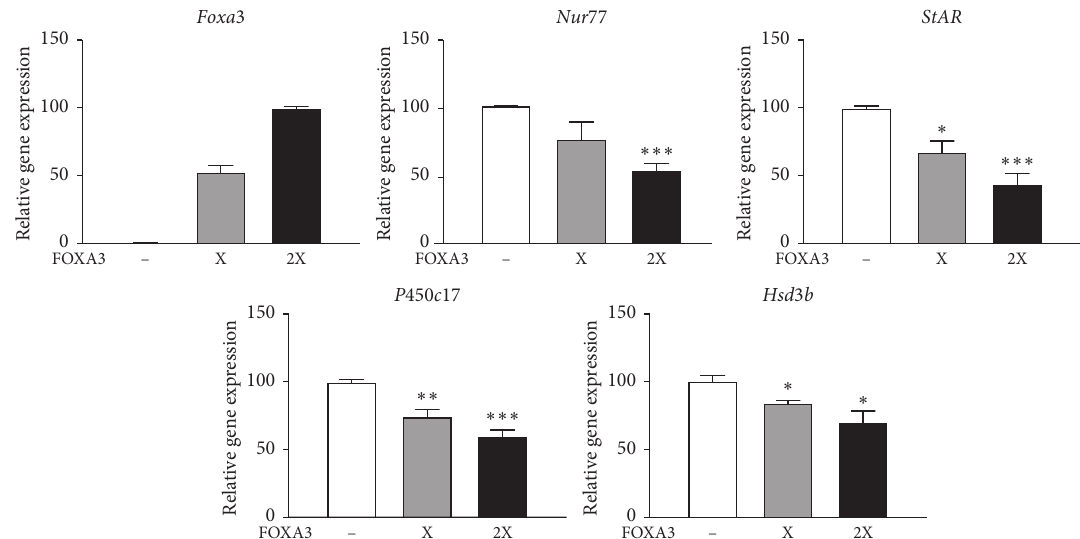
Figure 4: FOXA3 regulates the expression of Nur77 and steroidogenic genes. Expression of Nur77 and steroidogenic genes in MA-10 cells transfected with pcDNA3-only or pcDNA3-FOXA3 (X represents 200ng of the expression construct). After 44h of transfection, cells were treated with 200 μ M cAMP for 4h. Gene expression was quantified by qRT-PCR, and the gene expression level was normalized to that of GAPDH. The t -test was performed to analyze statistical significance. ∗ P < 0 . 01; ∗∗ P < 0 . 001; ∗∗∗ P < 0 . 0001 compared to cAMP-induced samples.